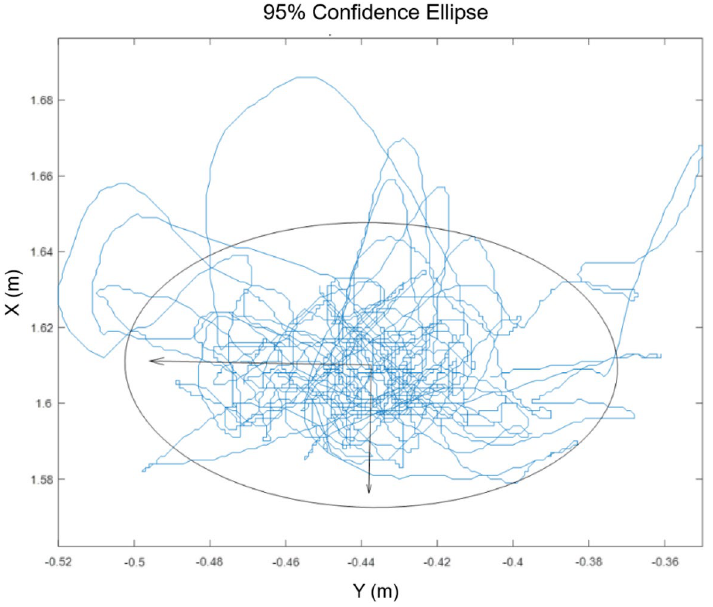
Figure 2. Example of a 95% confidence ellipse of head movements during VMRV in Standard